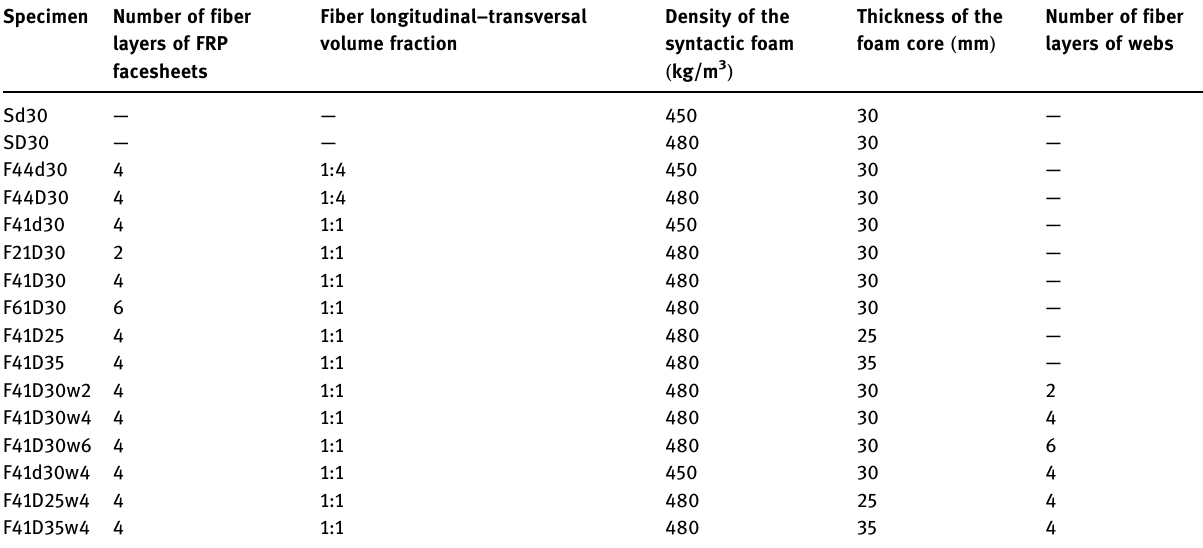
Table 3: Characteristics of the test specimens Specimen Number of fiber layers of